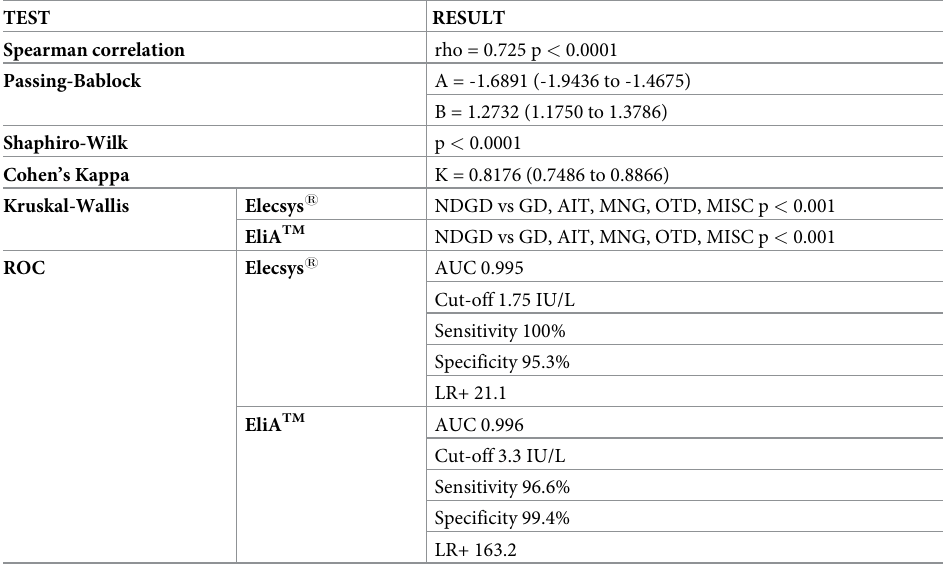
Table 3. Statistical analysis comparing results from Elecsys 1 and EliA ™ assays.